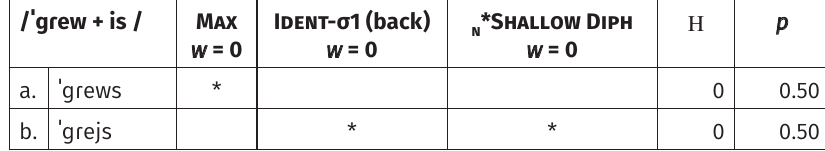
Table 6: Weightless constraints in the initial state; all candidates equally probable.